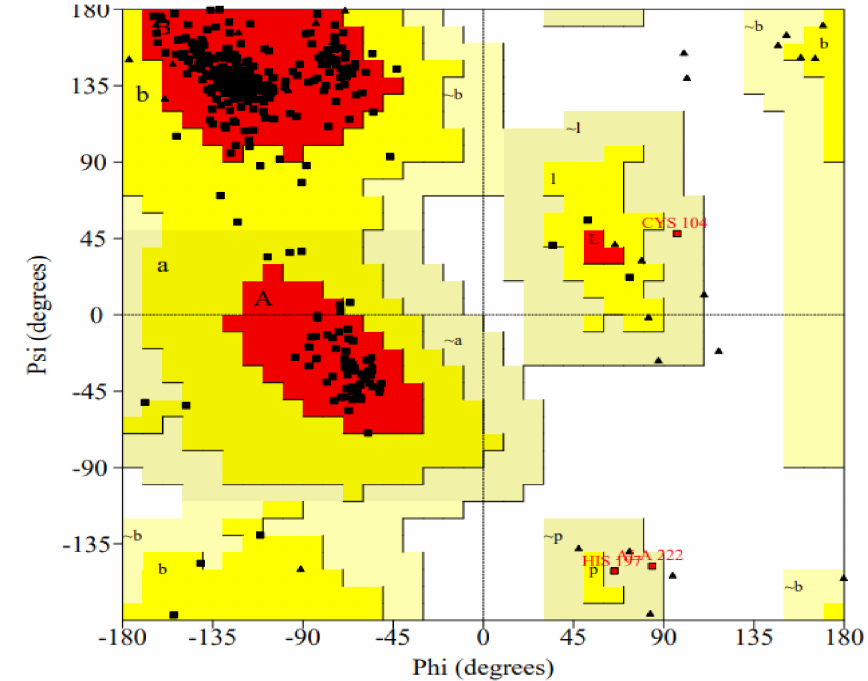
Figure 3. Ramachandran plot of the selected model.